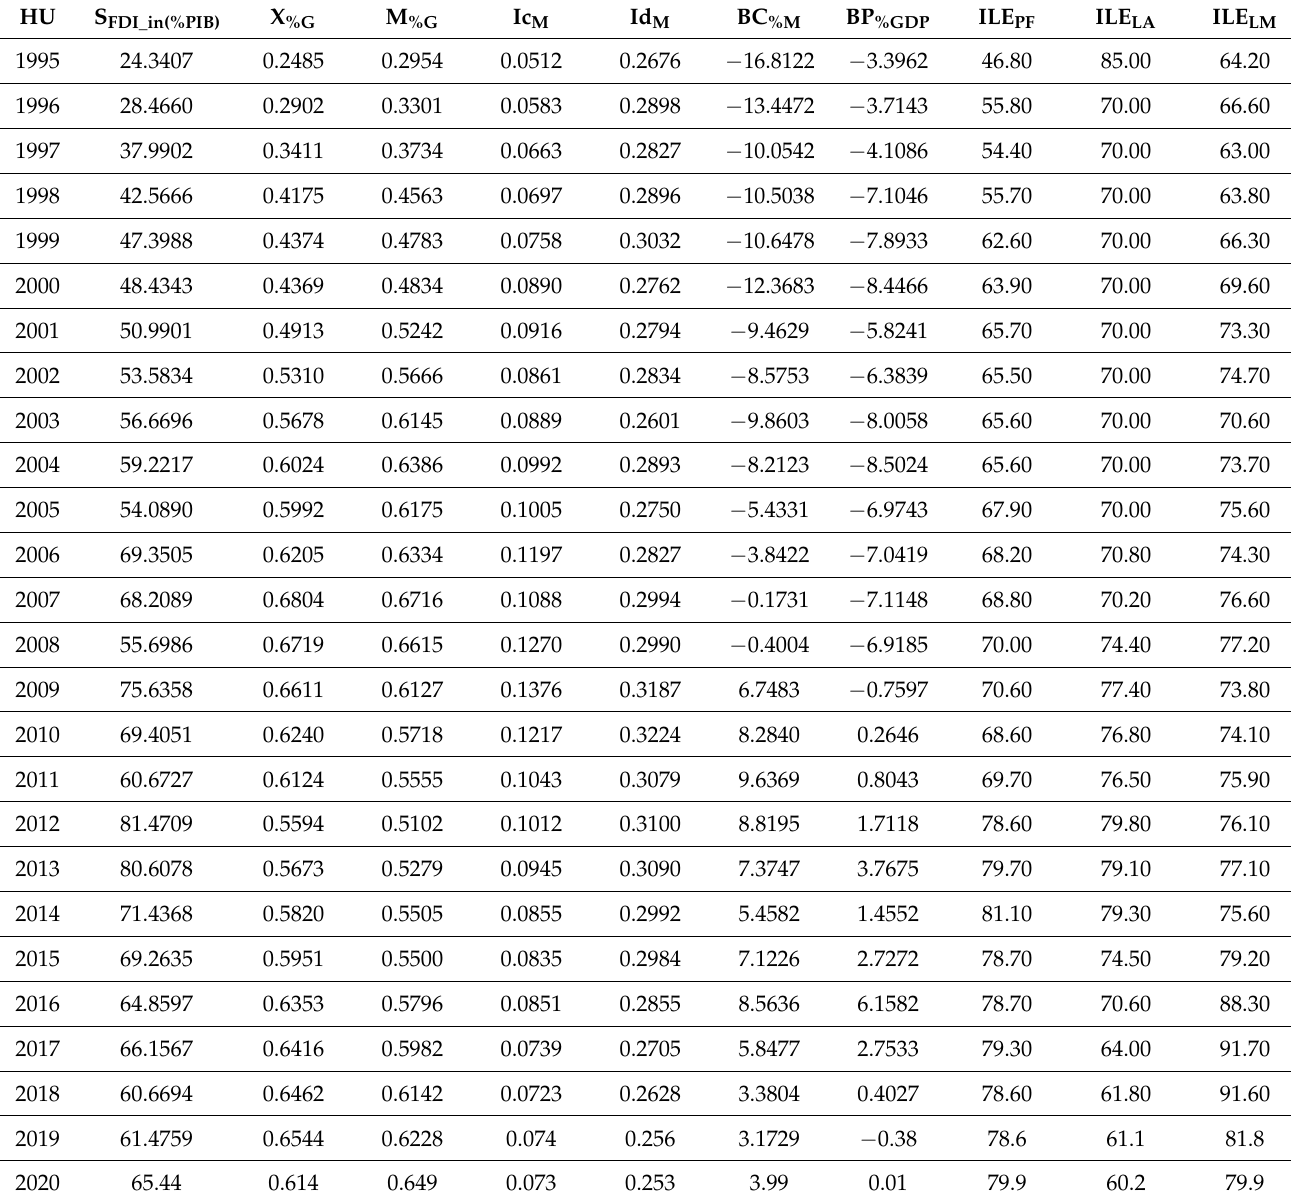
Table A2. Values of the economic indicators for